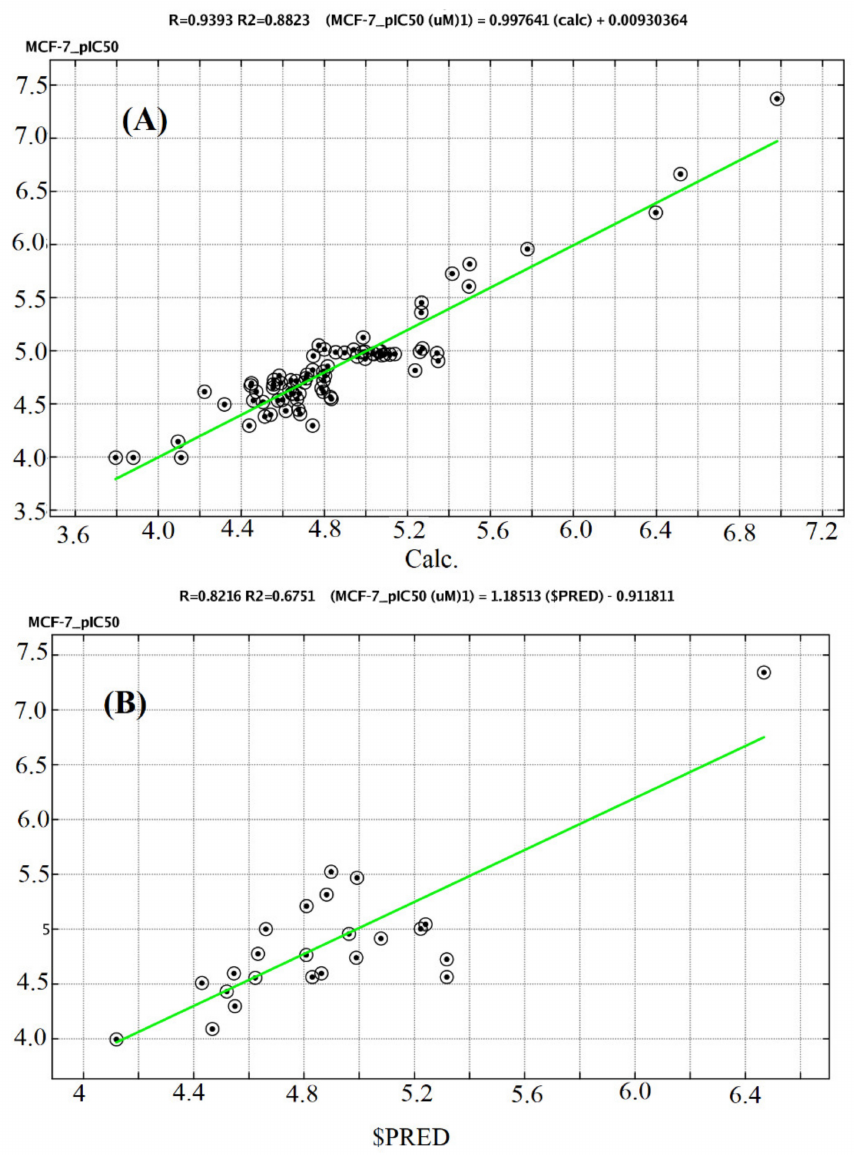
Figure 11. A plot of observed versus predicted pIC50 (MCF-7) of the training set ( A ) and testing set ( B